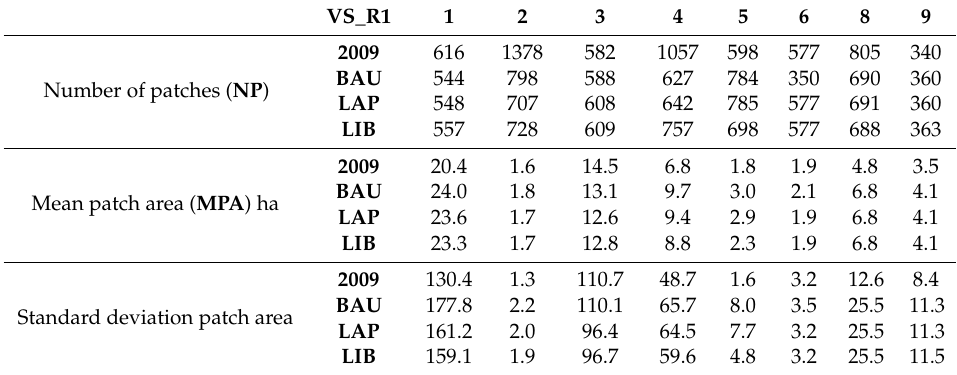
Table 9. Landscape fragmentation parameters for VS_R1: number of patches (NP), mean patch area (MPA) in ha, and standard deviation of the mean patch area, in 2009 and 2050 for each scenario and land use